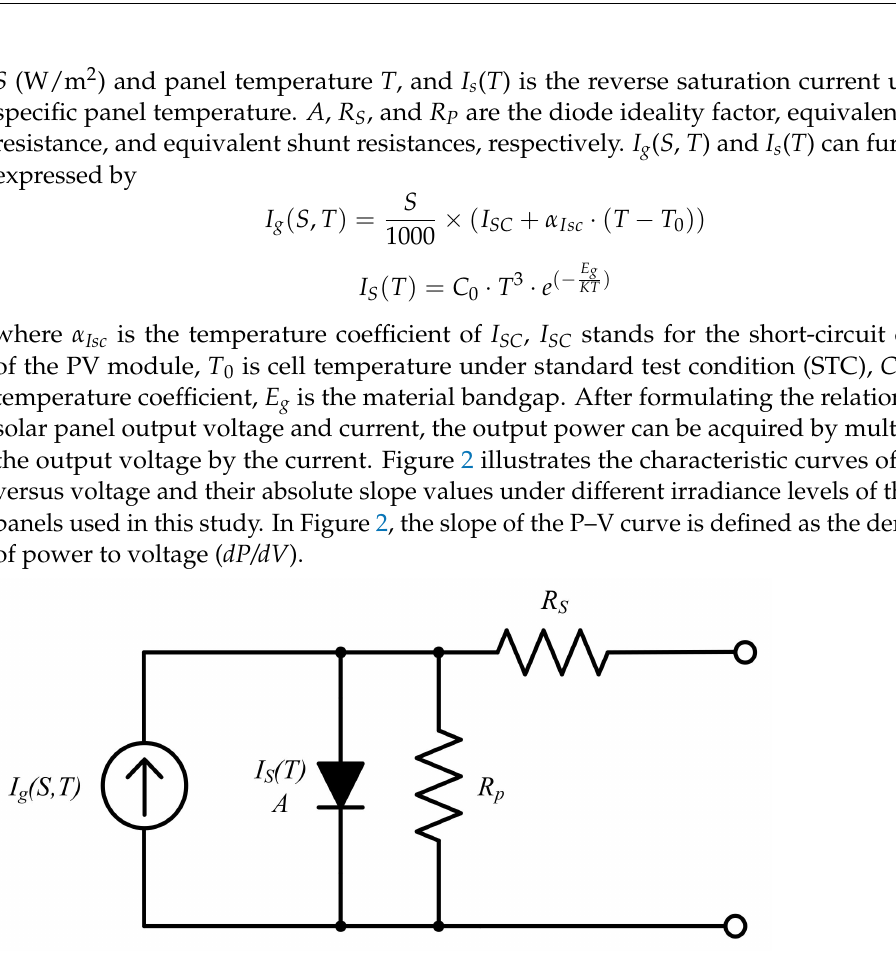
Figure 1. Single diode equivalent circuit model of the solar cell.